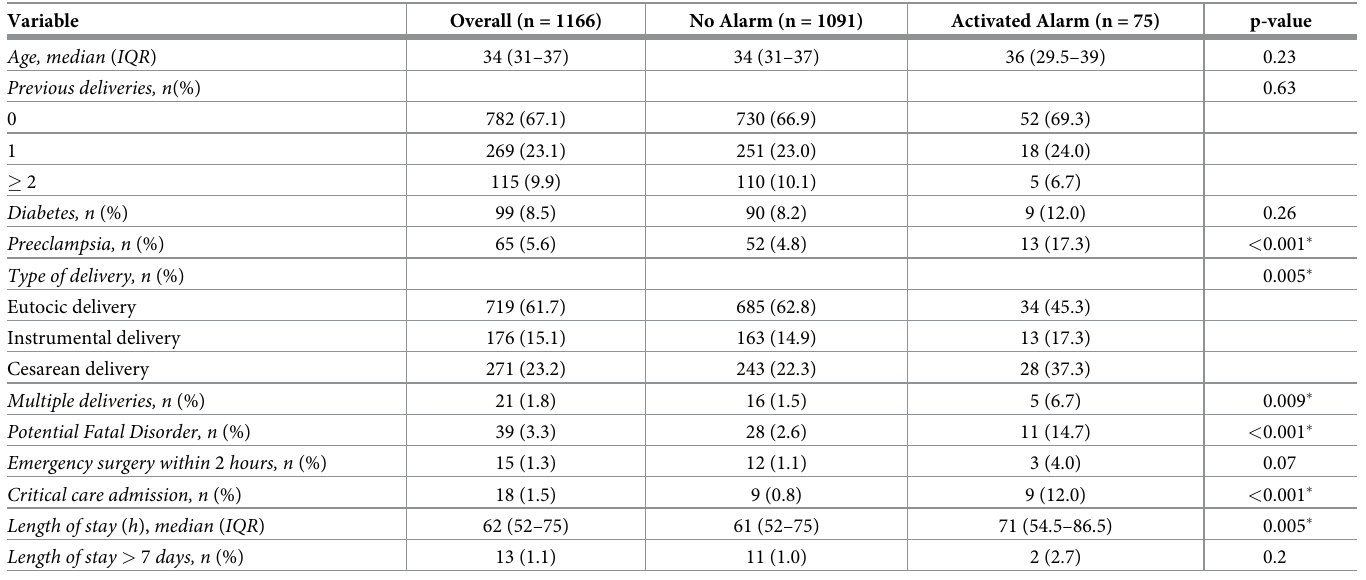
Table 1. Demographic data and outcome results according to MEWS protocol alarm activation.